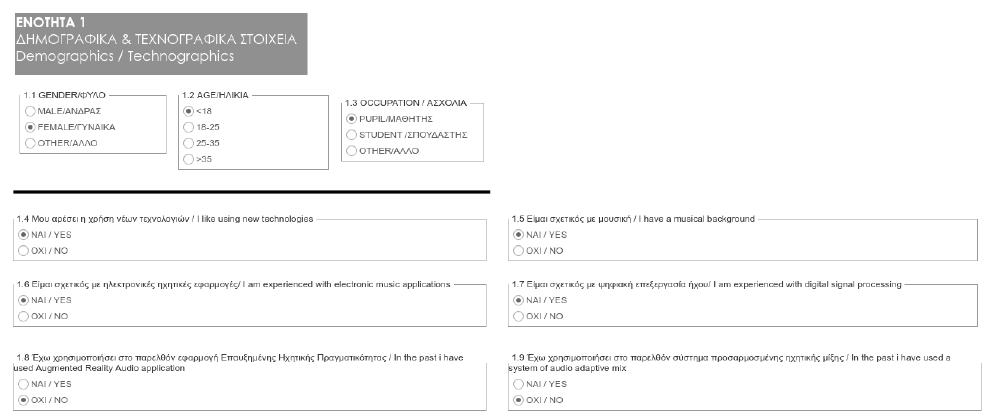
Figure A2. Demographics test